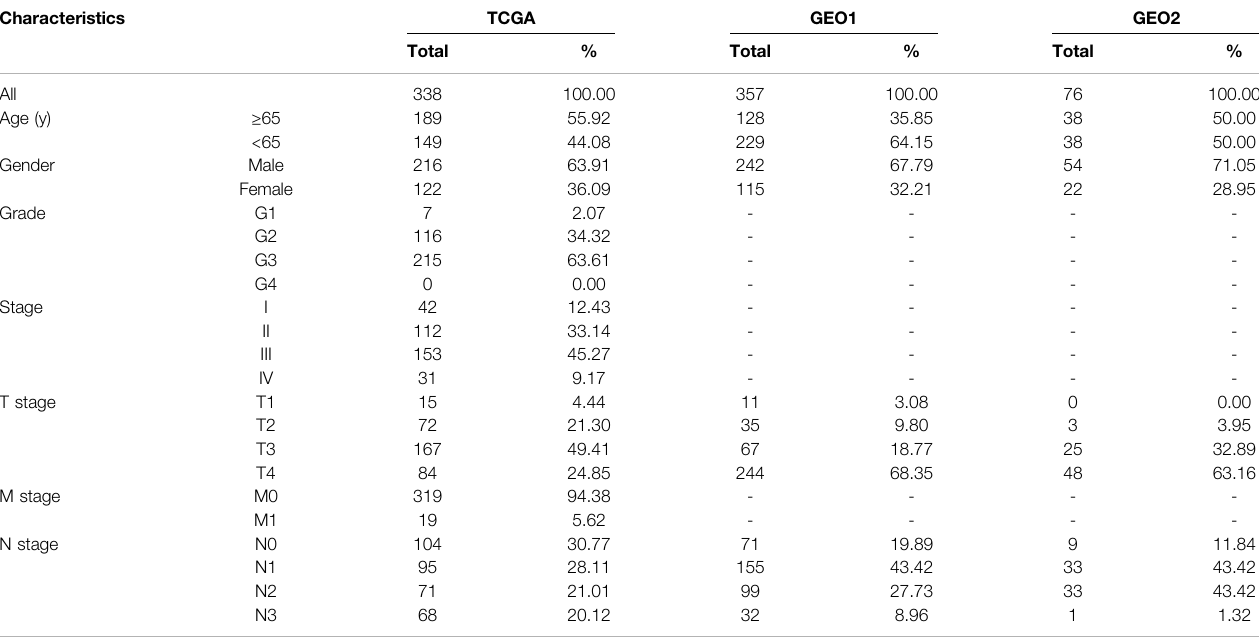
TABLE 1 | Clinical characteristics of STAD patients in the two databases.